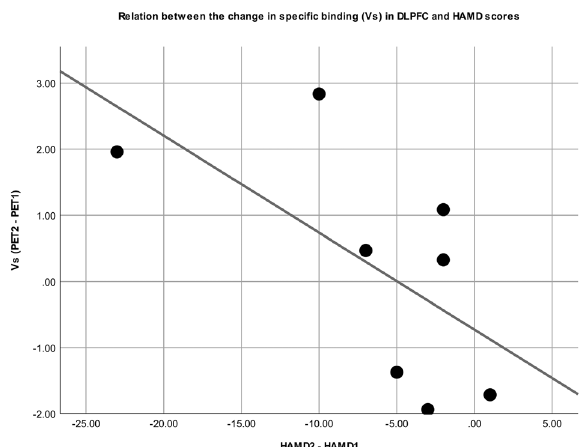
Fig. 2 Correlation between HAMD and 5-HT 1A receptor V s . Scatter plot showing the relationship between the Δ HAMD score and Δ V S between PET1 and PET2 in the TBS group. Spearman ’ s rank correlation showed r = 0.62 ( p = 0.099). Table 2. Average lateralization quotient of V S. Lateralization quotient was calculated for each time point and each group separately.